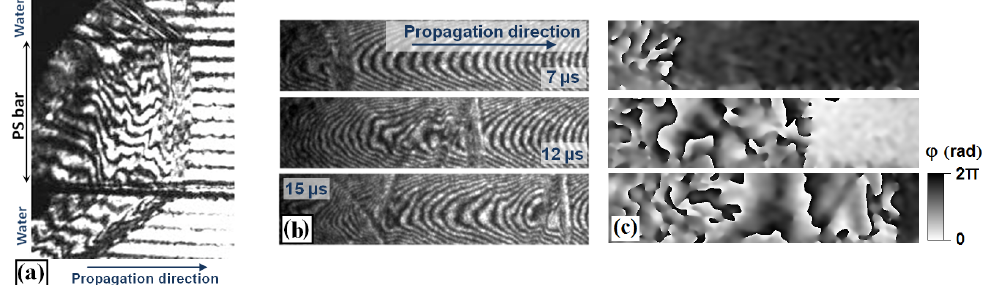
Figure 5. Initial stage of shock wave evolution after entering the polystyrene bar. ( a ) holographic interferogram; ( b ) set of digital holograms recorded during the first 15 µ s after shock wave generation; ( c ) phase distributions reconstructed from holograms ( b ). Note high amounts of rapidly oscillating components resulting in interference fringe breaks in ( a , b ) and phase wraps and singularities in ( c